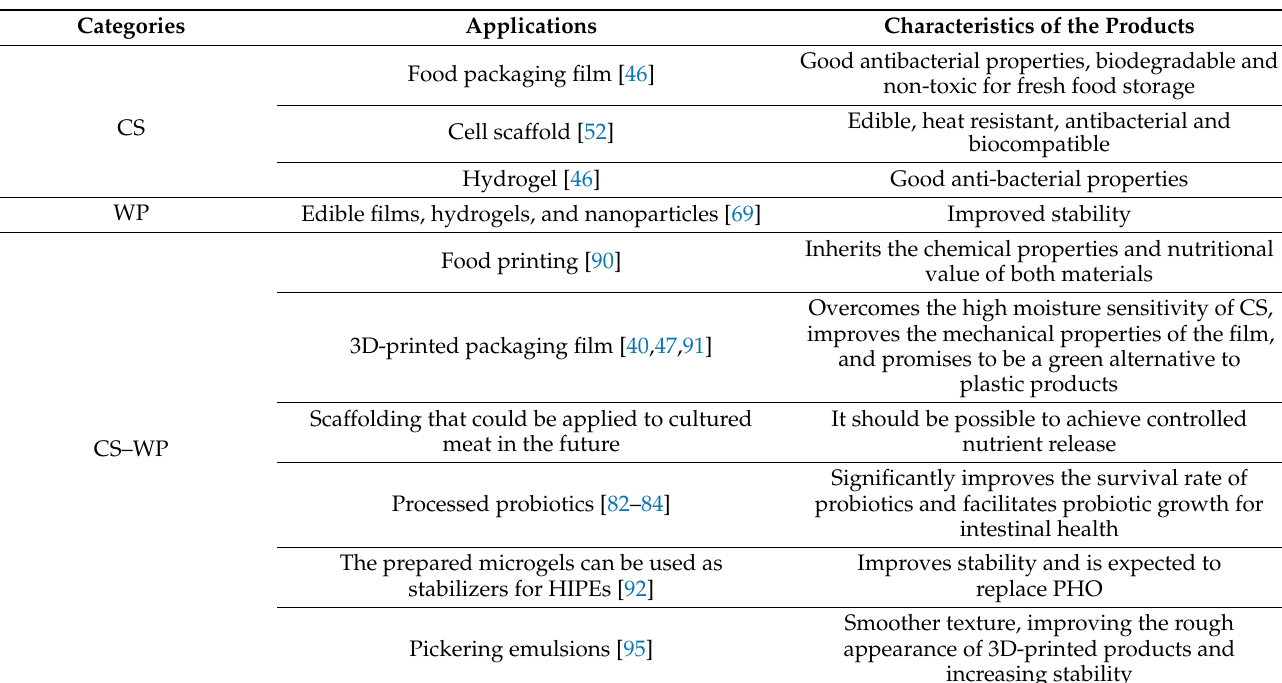
Table 3. Applications of CS, WP, and CS–WP with other different additives in 3D/4D printing and the characteristics of the printed